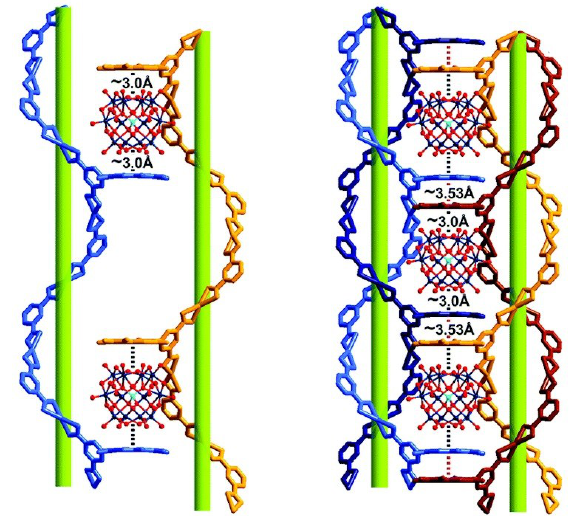
Figure 11. Keggin anions [SiW 12 O 40 ] 4− immobilized via anion–π interactions developed between POMs and NDIs ( left ). Structural analysis revealed two kinds of double-stranded helical chains with opposite handedness surrounded by NDI–NDI–POM–NDI–NDI sandwich arrays ( right ). Adapted from Dalton Trans. 2017 , 46 , 4898–4901. Copyright (2017) Royal Society of Chemistry.